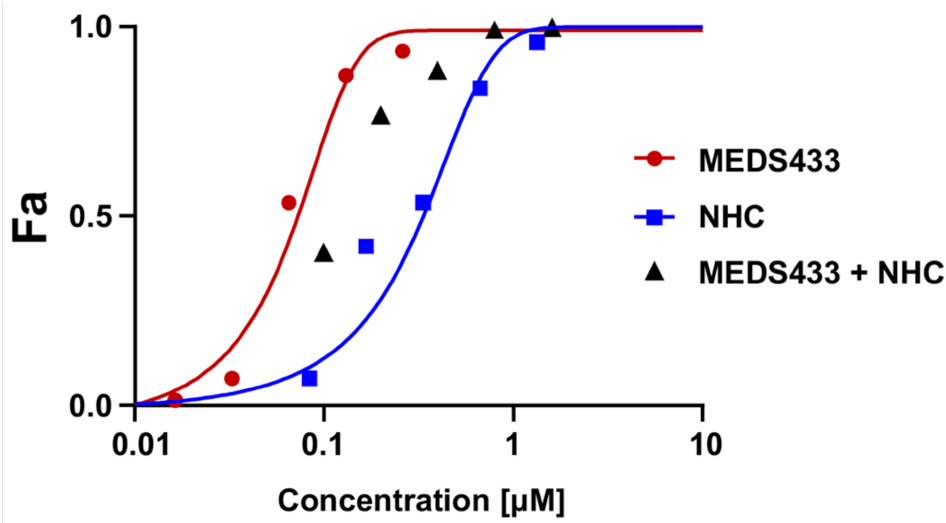
Figure 8. The combination of MEDS433 with NHC is synergistic against IAV replication. A549 cells were treated with different concentrations of MEDS433 alone or in combination with various concentrations of NHC before and during IAV infection. At 48 h p.i., the cell supernatants were harvested and titrated for IAV by the plaque assay in MDCK cells. Viral titers were analyzed by the CompuSyn software 1.0 [36], and the anti-IAV activity is shown as a fractional effect analysis (Fa) plot in relation to the drugs’ concentrations. Red and blue Fa curves represent the activity of MEDS433 or NHC on IAV replication when employed as single agents, respectively. The effect of the MEDS433–NHC combination is shown with black triangles. Results are representative of three independent experiments performed in